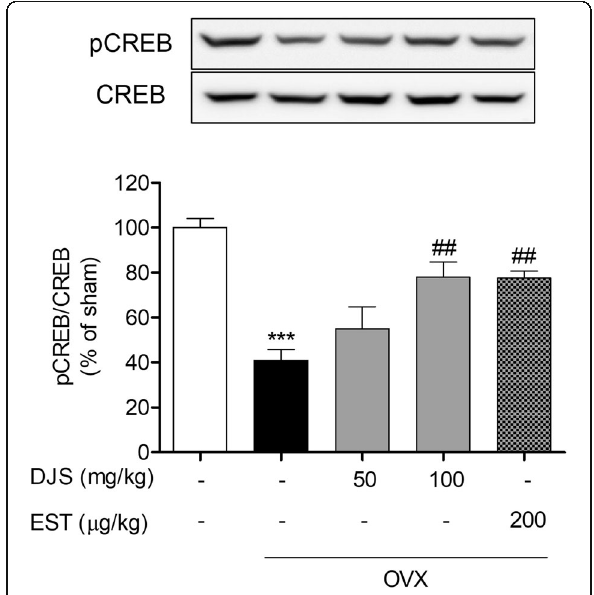
Fig. 3 Effects of DJS on activation of CREB signaling in the mouse hippocampus. Expression of pCREB and CREB was assessed by Western blot analysis using pCREB and CREB antibodies. *** p < 0.001 compared with the sham group, ## p < 0.01 compared with the OVX